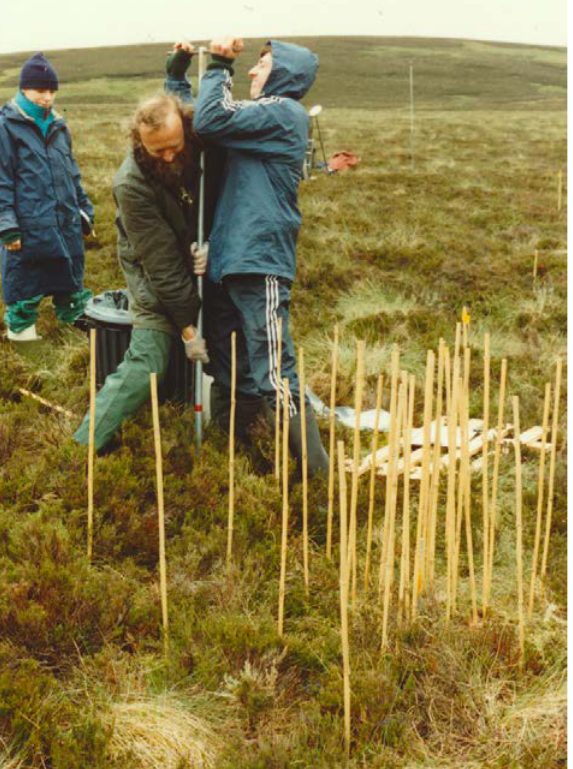
Figure 5. Bamboo cane ‘forest’ marking the places to be sampled around an injection site. People: MG, BRG, SV. Samples were taken from positions distant from the injection site before those nearer the injection site (to minimise contamination).